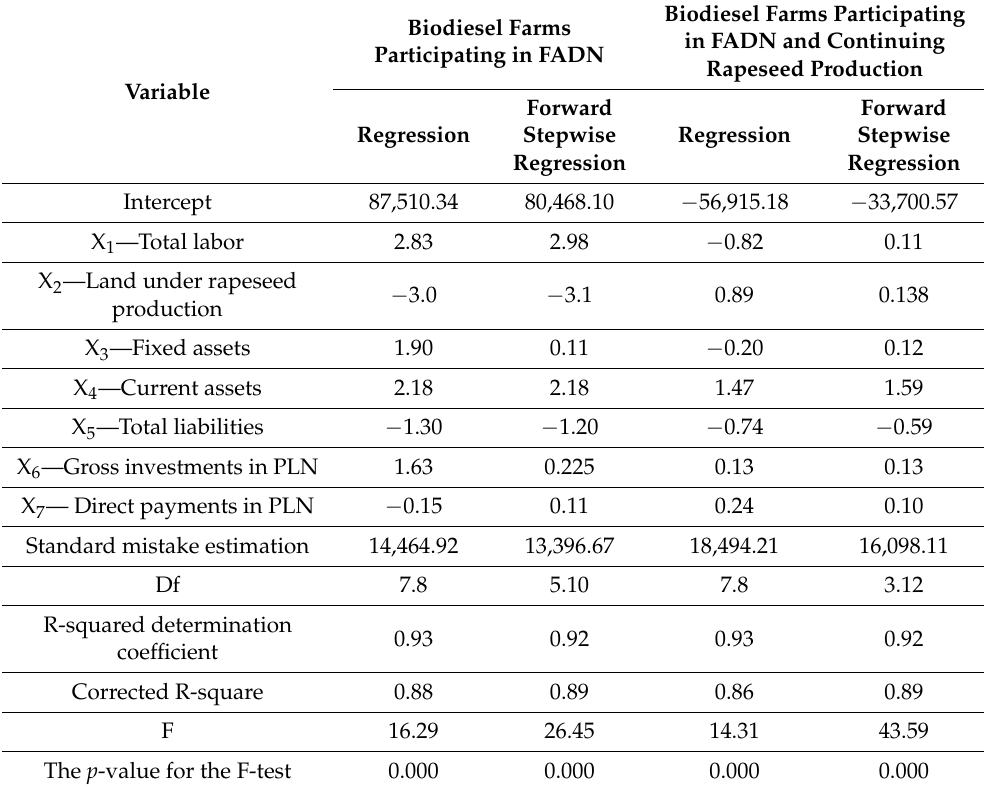
Table 9. Results of the multiple regression analysis investigating the relationship between the dependent variable Y 1 (farm household income) and the explanatory variables. Biodiesel Farms Participating Biodiesel Farms in FADN and Participating in FADN Variable